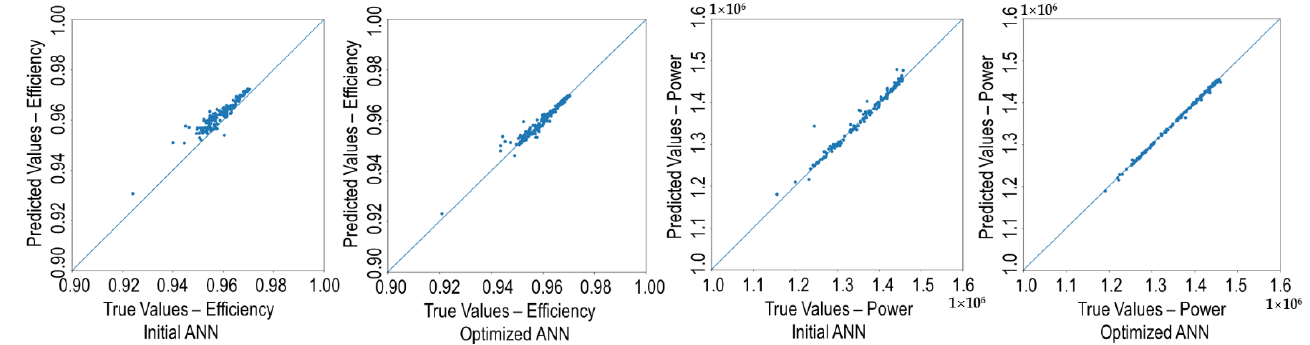
Figure 3. Predicted vs. true values of the initial and optimized ANN models.